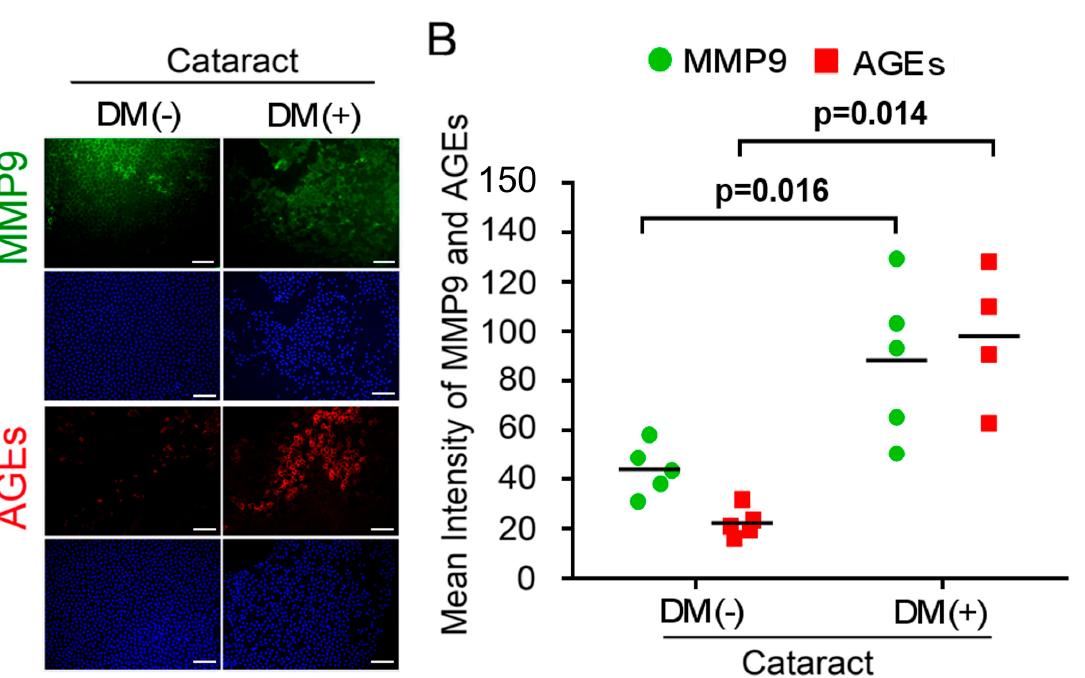
Figure 1. Expression of matrix metalloproteinase 9 (MMP9) and advanced glycation end products (AGEs) in the lens of DM (+) and DM ( − ) cataract patients. ( A , B ) Representative images of MMP9 − positive (green), AGEs-positive (red) cells, and cell nuclei counterstained with DAPI (blue) in the lens of epithelial tissue from cataract DM (+) and DM ( − ) patients. Data represented mean ± SEMs ( n = 6 per group, separate experimental groups in each figure).